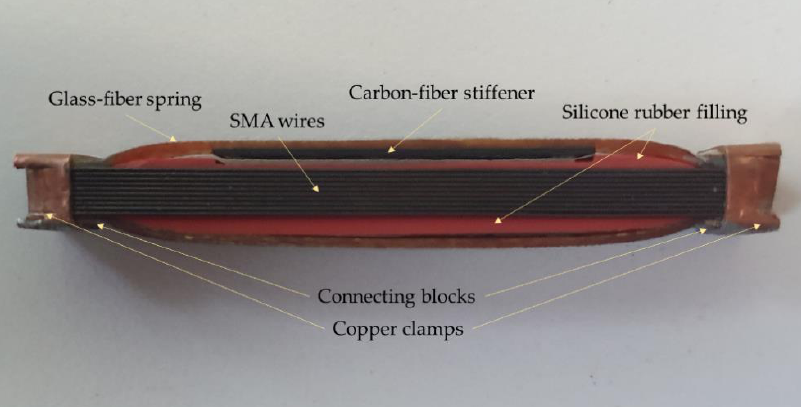
Figure 5. Structure of a fish-mouth actuator with shape memory alloy (SMA) wires based on [71,72].